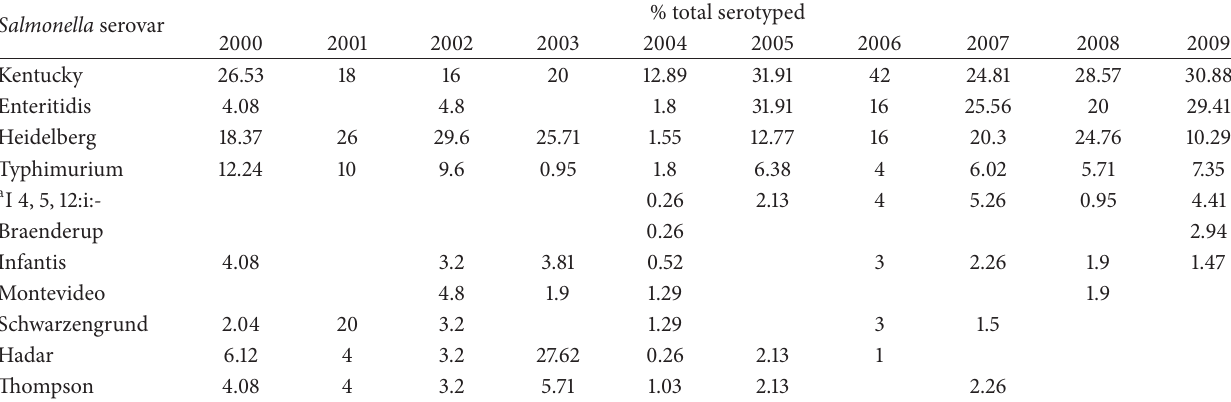
Table 6: Examples of Salmonella serovars profiles from samples of ground chicken collected in the US [36]. Salmonella